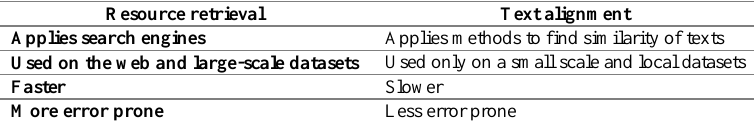
Table 1. Comparison between resource retrieval and text alignment techniques. Resource